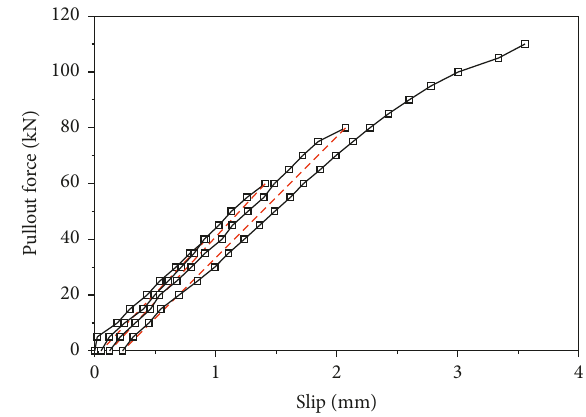
Figure 14: Cyclic load-slip curves obtained under unconstrained